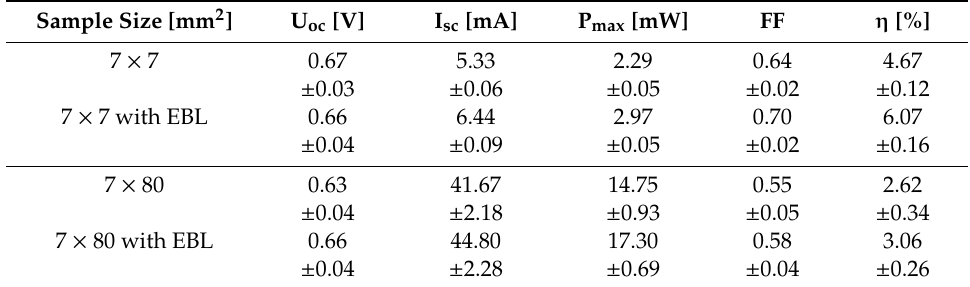
Table 2. DSSC parameters for 7 × 7 mm 2 and 7 × 80 mm 2 devices with and without a TiO 2 electron blocking layer.